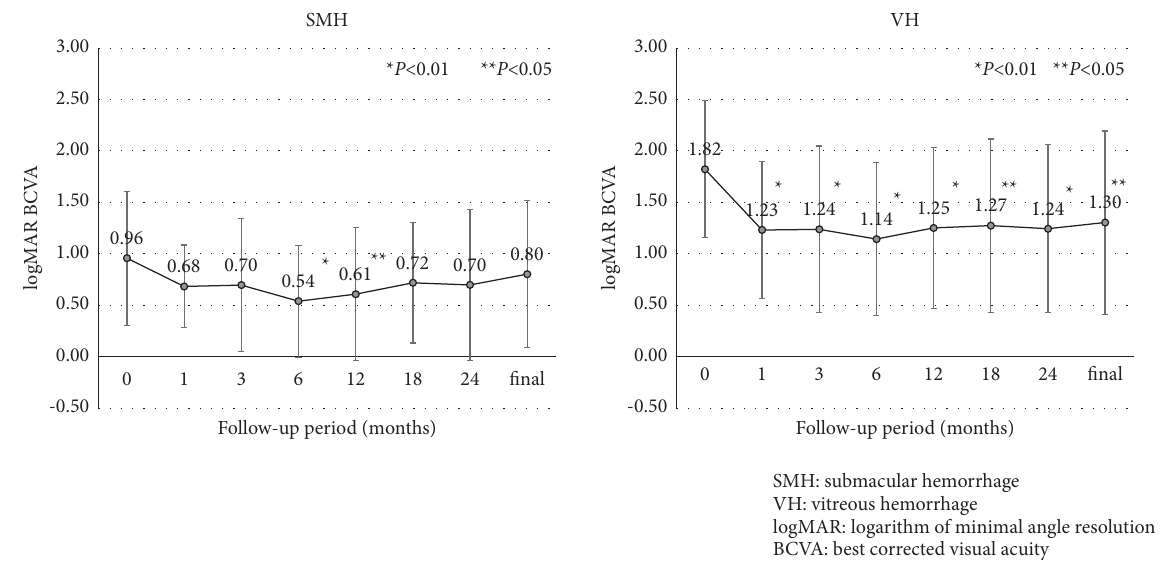
Figure 1: Mean best-corrected visual acuity (BCVA) (logMAR) in an eye with (a) SMH and (b) VH.